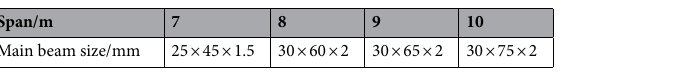
Table 7. Skeleton size